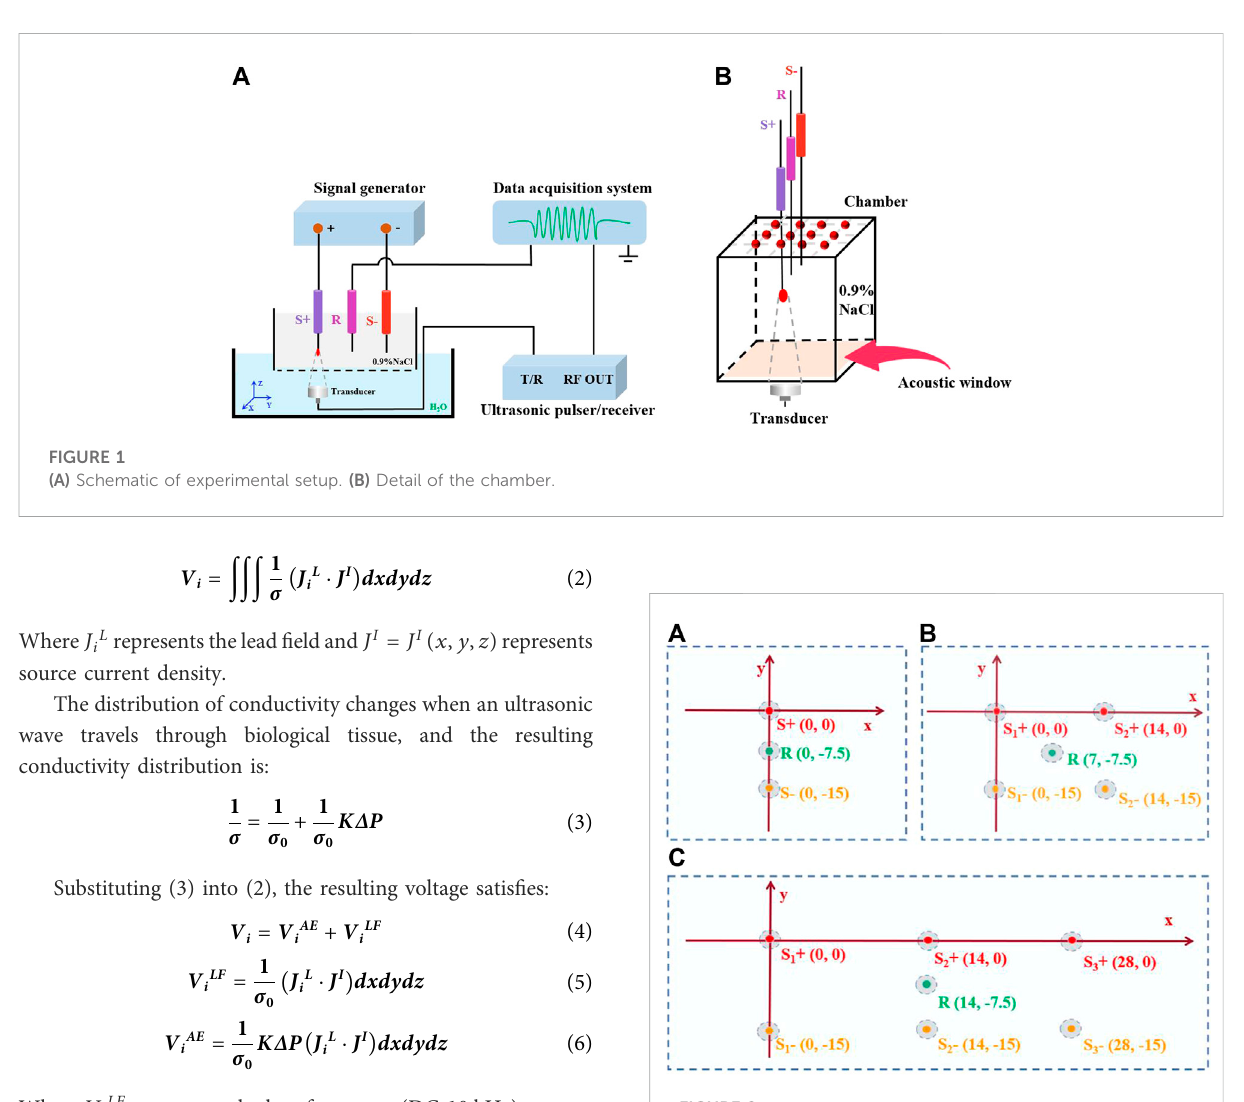
FIGURE 2 Experimental design for decoding performance evaluation. (A) Is the 1-source diagram. (B) is the 2-source diagram. (C) is the 3-sourcediagram.S+isthepositiveelectrodeplacementposition. R is the recording electrode placement position. S- is the negative electrode placement